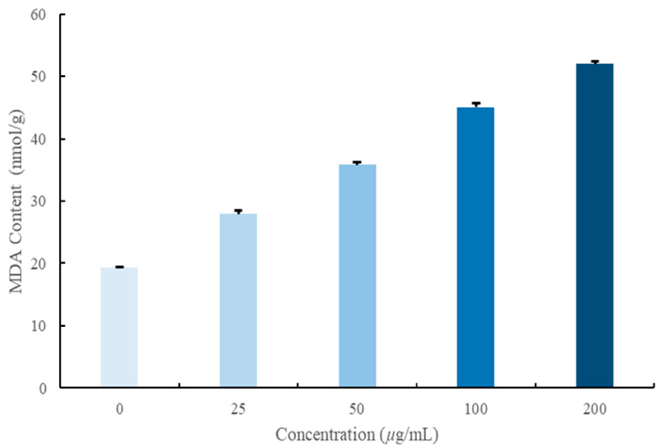
Figure 9. MDA content of S. sclerotiorum after treatment with W12 .